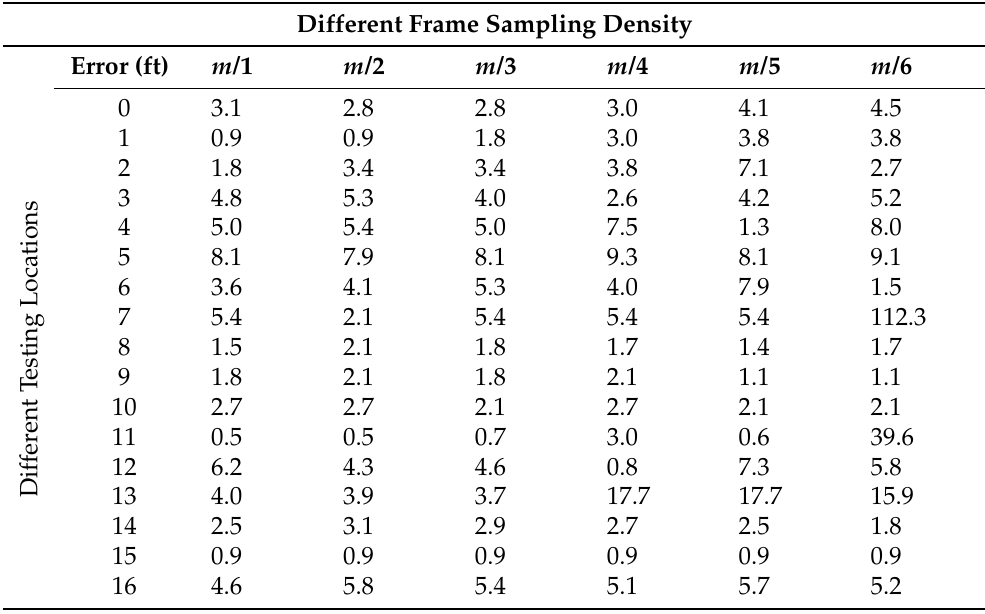
Table 3. Estimated location errors (ft) at 17 testing locations with different direction downsampling